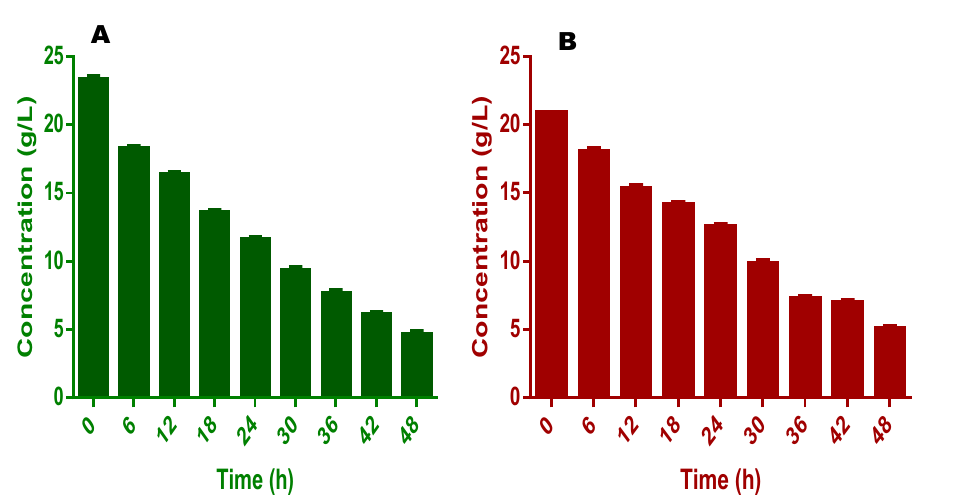
Figure 3. This figure shows the pattern of volatile solids (VS) conversion for ( A ) food wastes and ( B ) spent animal beddings during the